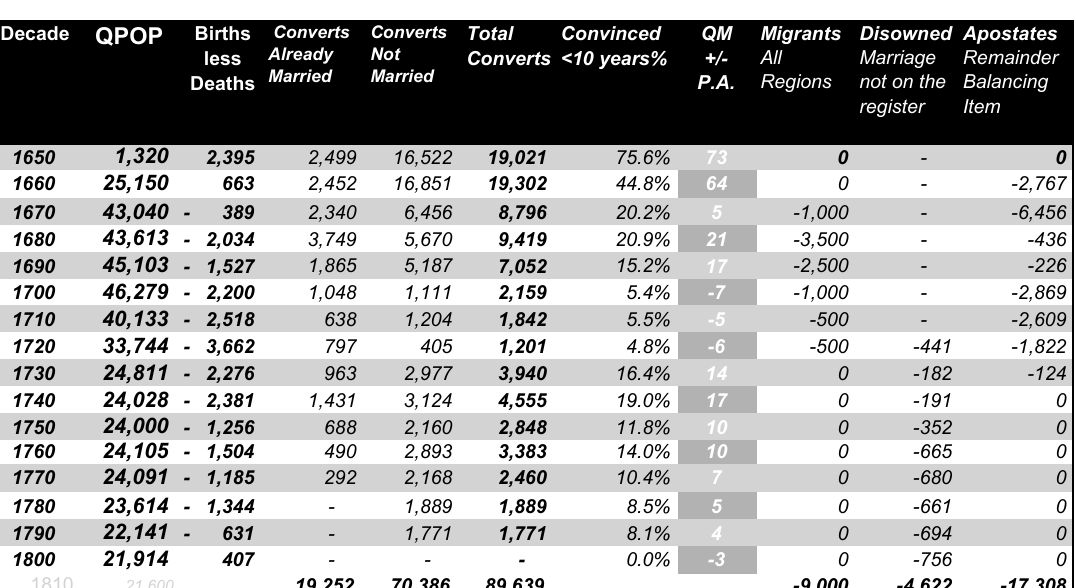
Figure 7. The projected QPOP model compared with Rowntree. Table 4. English QPOP stock: convinced, migrant, apostate and disowned flows.